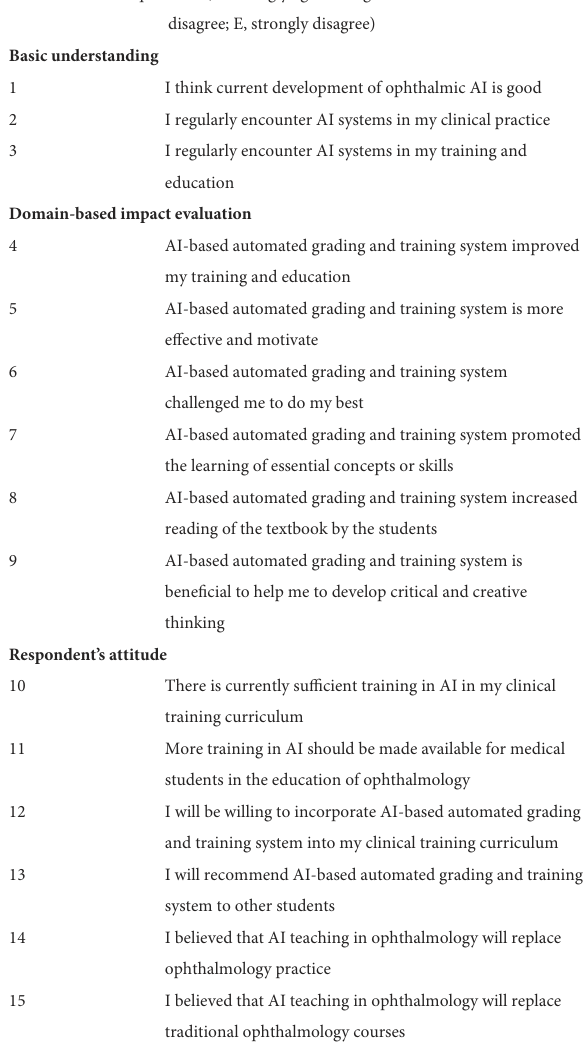
TABLE 1 15-item